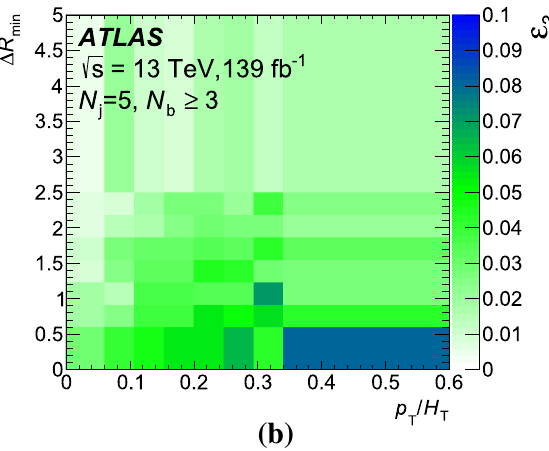
Fig. 3 Two-dimensional distributions of the probability a ε 2 or b ε 3 of b -tagging an additional jet in a sample of events with a at least two or b at least three b -tagged jets as a function of the ratio of jet transverse momentum to H T , p T / H T , and the minimum (cid:9) R between the jet and